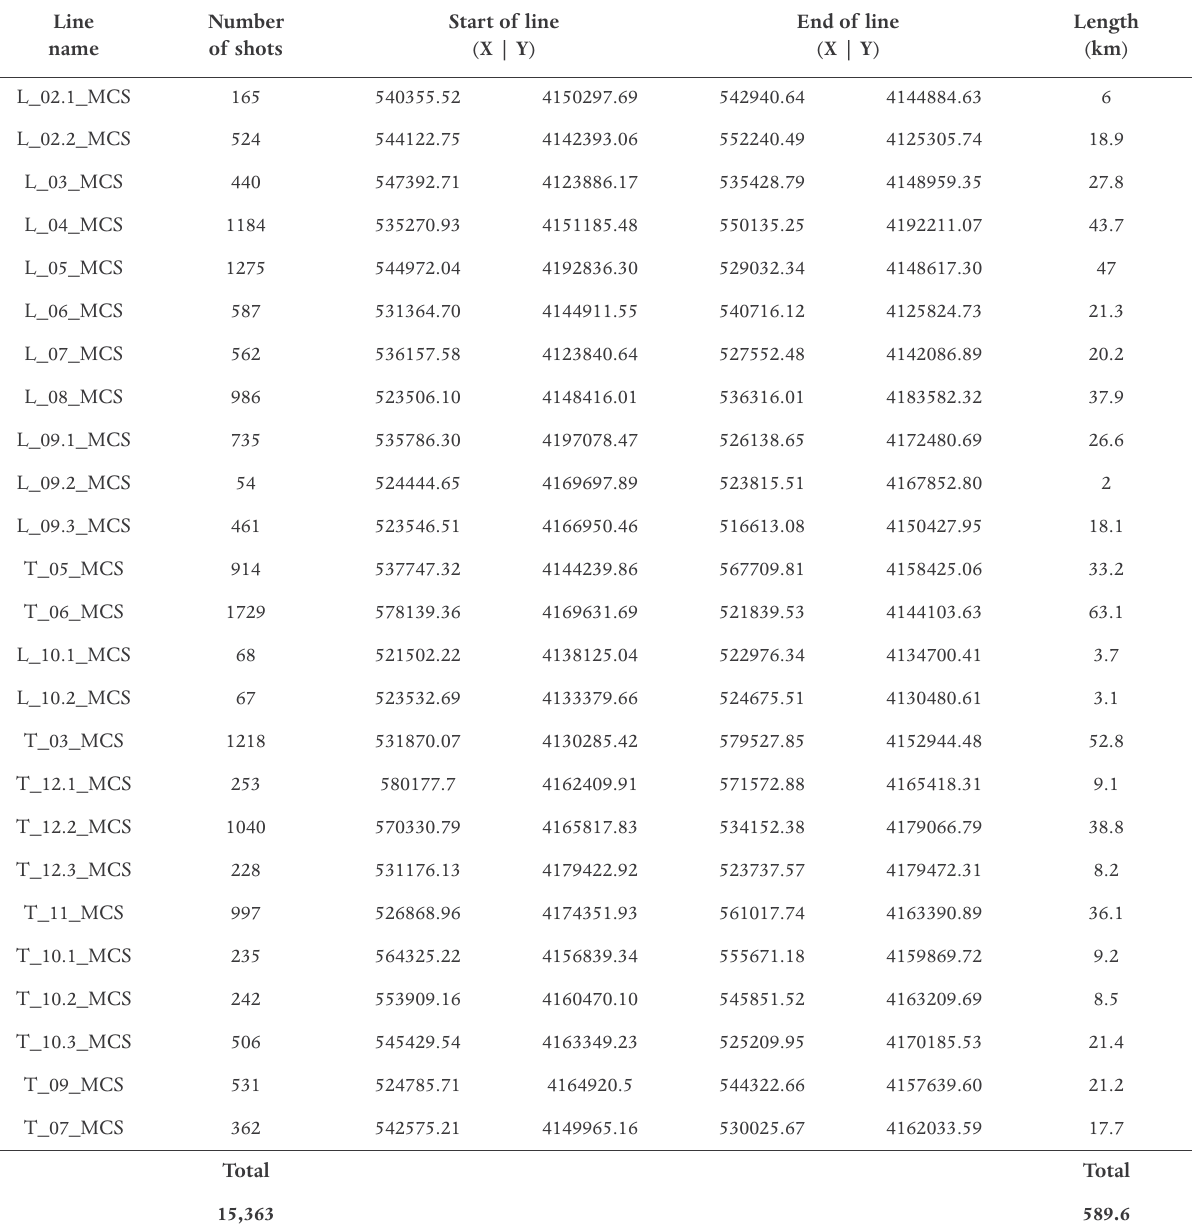
Table 1. Main characteristics of MCS lines acquired in the Ionian Sea area, during the TOMO-ETNA oceanographic cruise with the R/V “Sarmiento de Gamboa”. The coordinate are projected in UTM-WGS84, zone